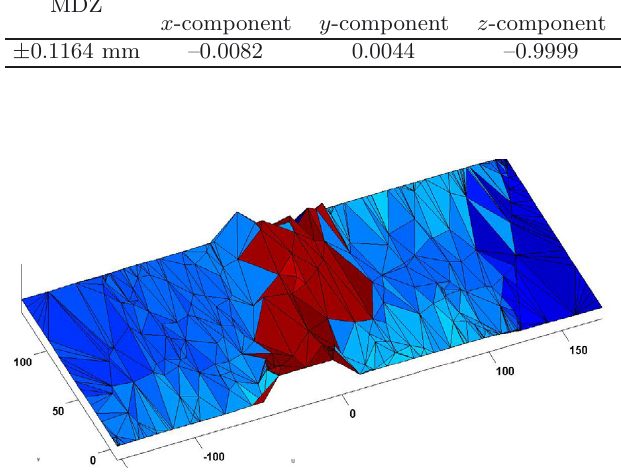
Fig. 1. Geometric form details of the inspected surface with 10 ×